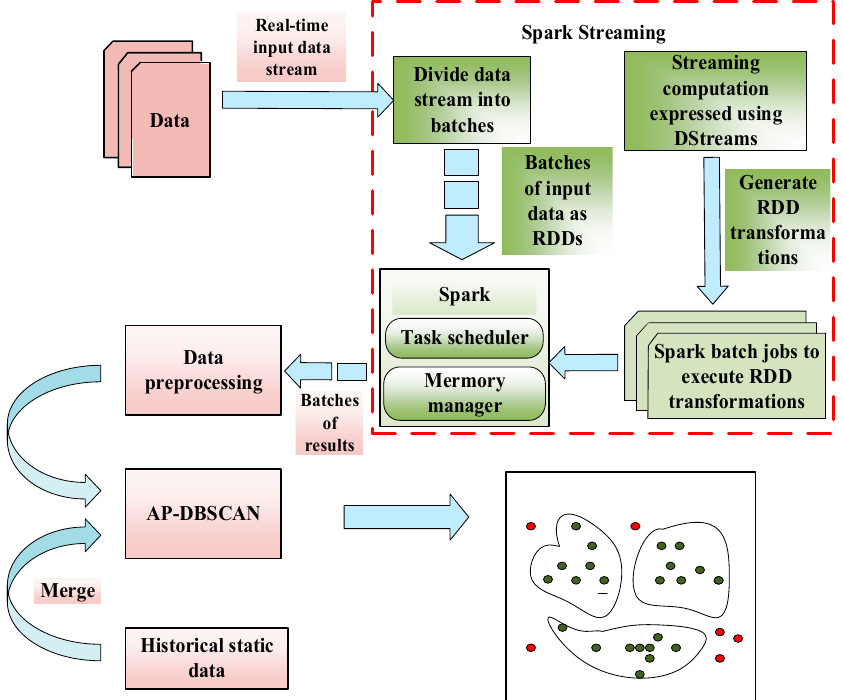
Figure 1. Adaptive parameters density-based spatial clustering of applications with noise (AP-DBSCAN) clustering analysis based on the Spark Streaming mechanism.